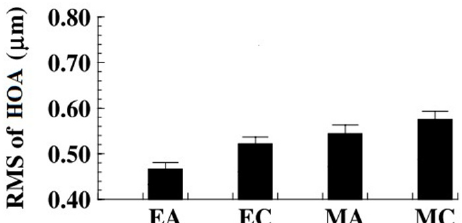
Figure 4. Mean RMS of HOAs (from fourth to seventh orders of Zernike aberrations) for emmetropic adults (EA), emmetropic children (EC), myopic adults (MA), and myopic children (MC). Adapted with permission from Ref. [51] “Wavefront aberrations in eyes of emmetropic and moderately myopic school children and young adults” by j. He, R. Held, F. Thron, X. Sun, J. Gwiazda, 2002, Vision Res., Volume 42(8), 1067, Copyright @2002, Elsevier. (https://doi.org/10.1016/s0042-6989(02)00035-4).